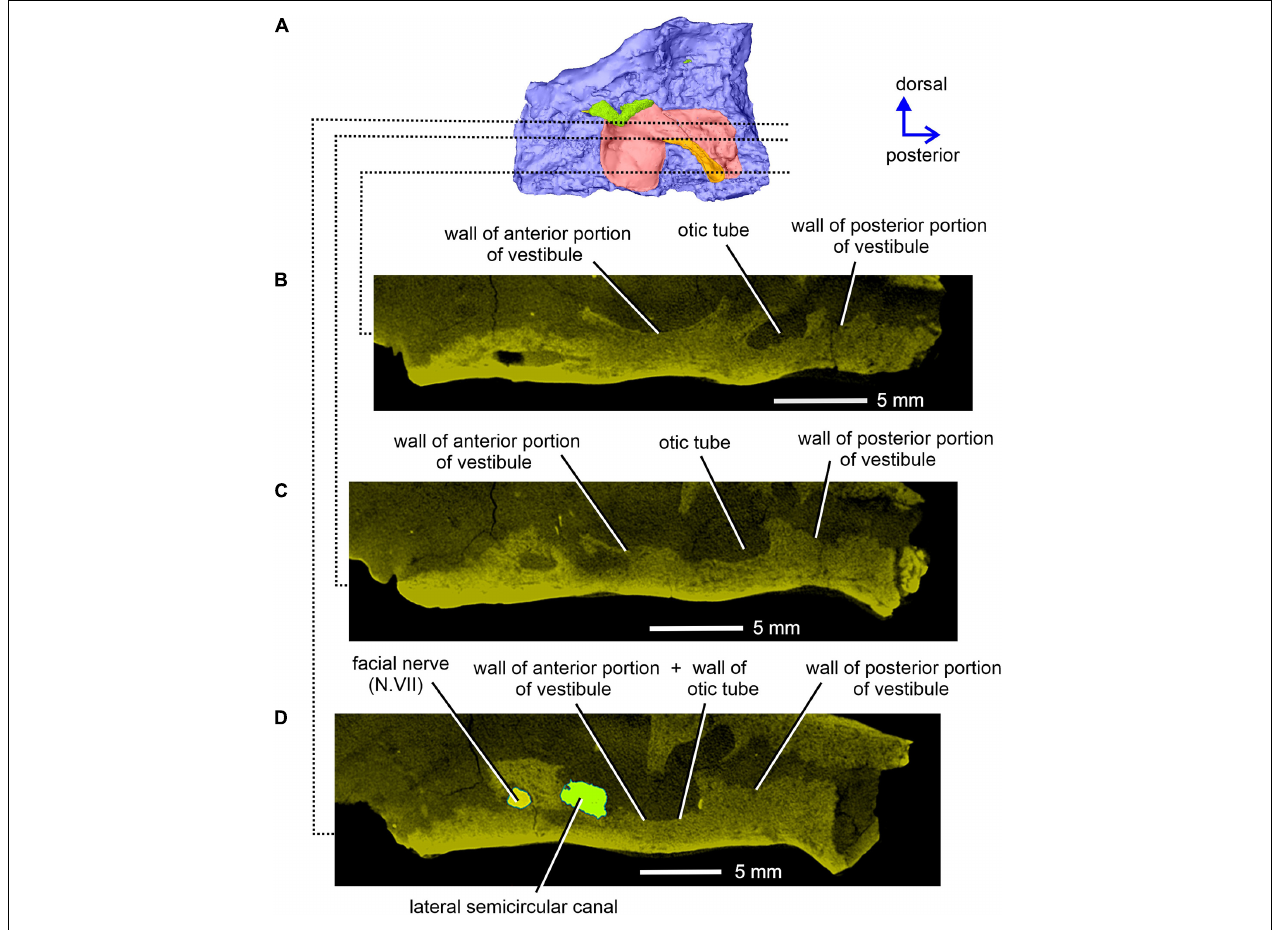
FIGURE 11 | Limnoscelis dynatis , CM 47653. Longitudinal CT sections through the right prootic in medial view (A) from ventral to dorsal (B–D)